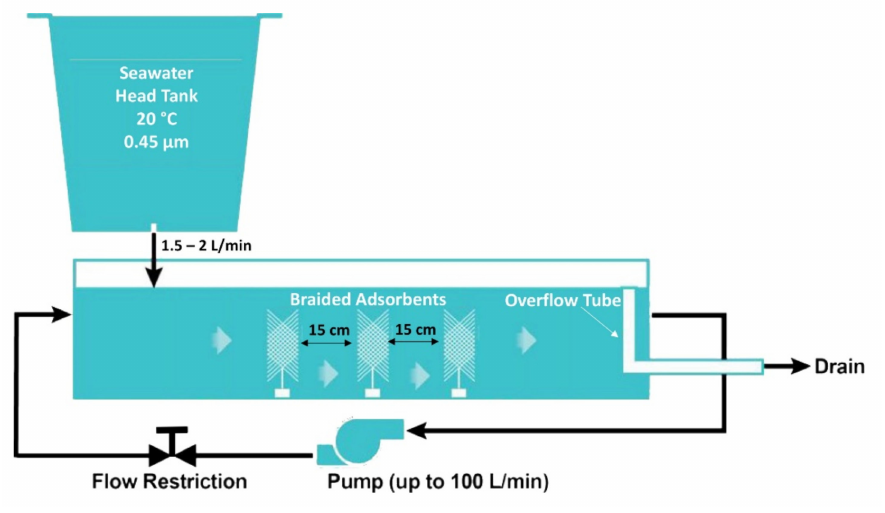
Figure 2. Conceptual side-view of a flume